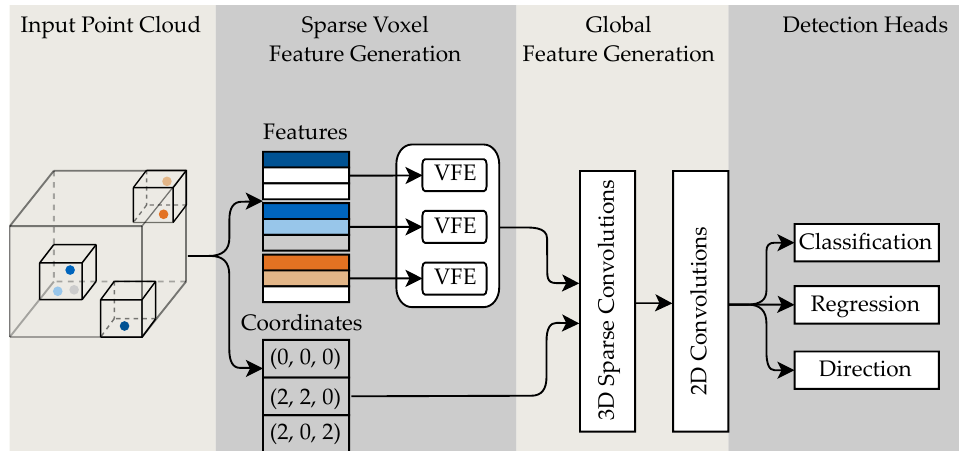
Figure 1. Network architecture of the proposed RVF-Net.